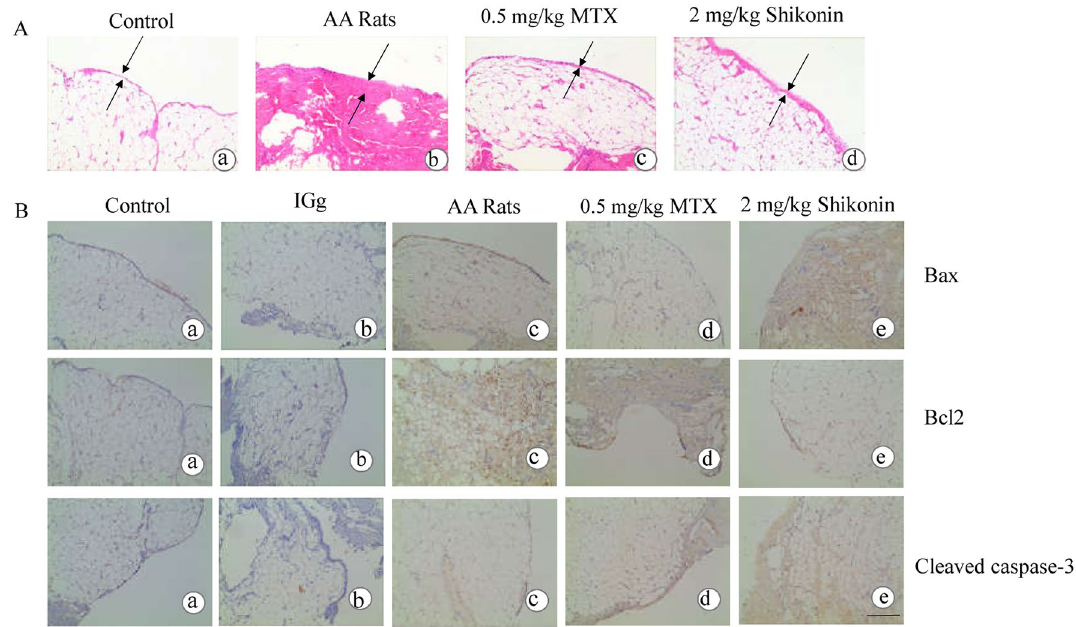
Figure 6. Effects of shikonin on the synovial histopathology of AA rats and the expression of Bax, Bcl-2, and cleaved caspase 3 in rat synovial tissue. ( A ) H&E-stained images of AA rats synovial tissue from the control group, AA group, and shikonin group at 32 days, where black arrows mark synovial hyperplasia. ( B ) Immunohistochemical staining of Bax, Bcl-2, and cleaved caspase 3 in the synovial tissue of AA rats from the control group, IGg group, AA group, and shikonin group. Scale bar represents 200 μm. Data are representative of at least three independent experiments.